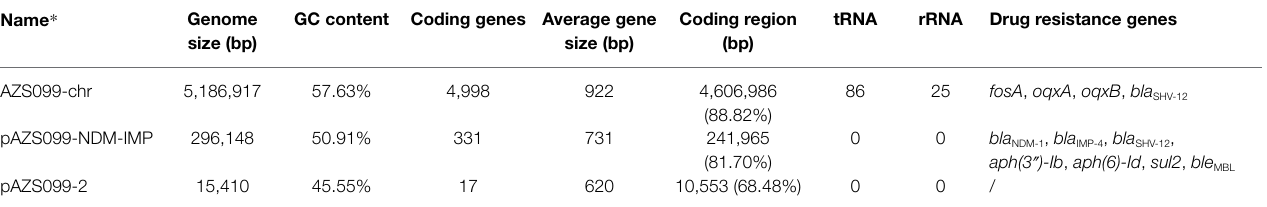
TABLE 2 | The genomic characteristics and antimicrobial resistance genotype analysis of the sequences of chromosomes and plasmids.